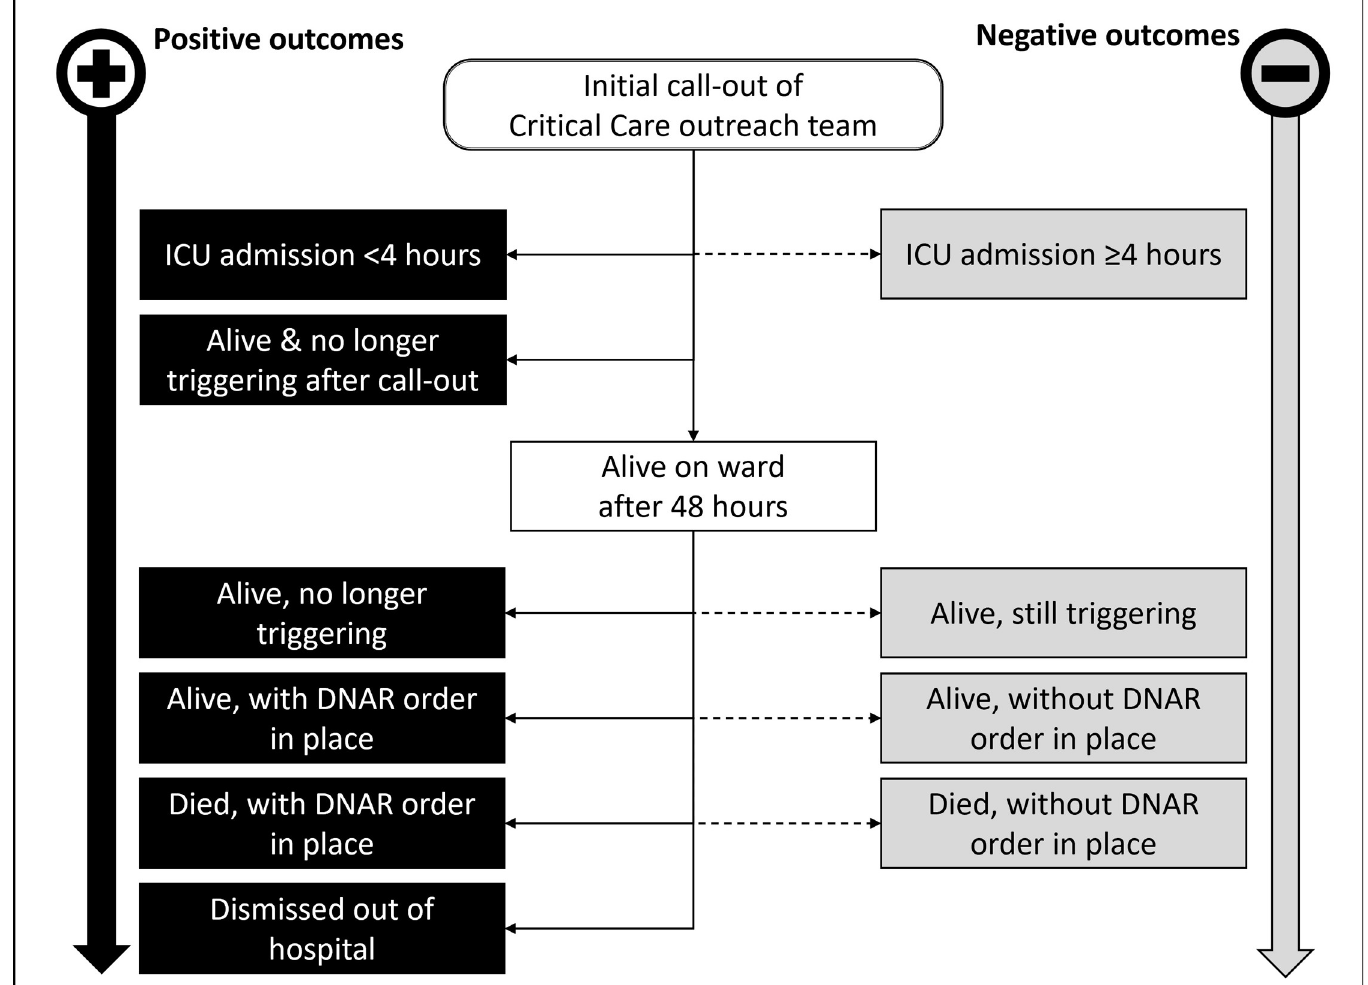
Fig 1. Flow chart MAELOR